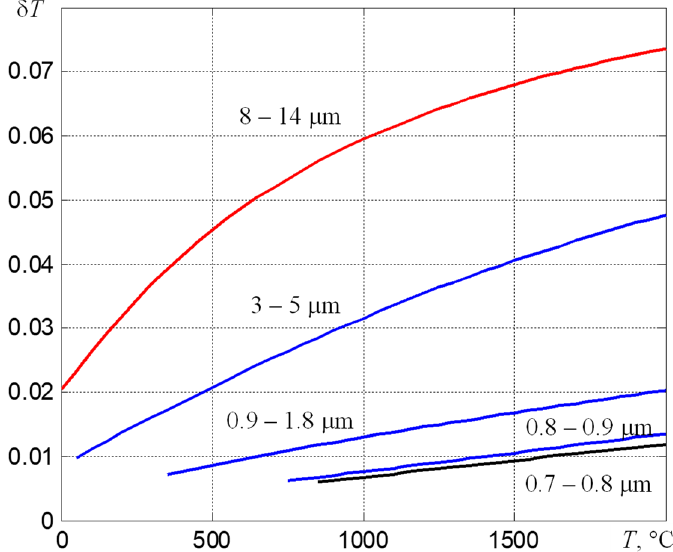
Figure 4. Temperature dependences of the relative errors δ T for determining the true temperature of bodies with thermal imagers of partial radiation, which use typical spectral ranges, at a relative uncertainty of the value of ε equal to 0.1.